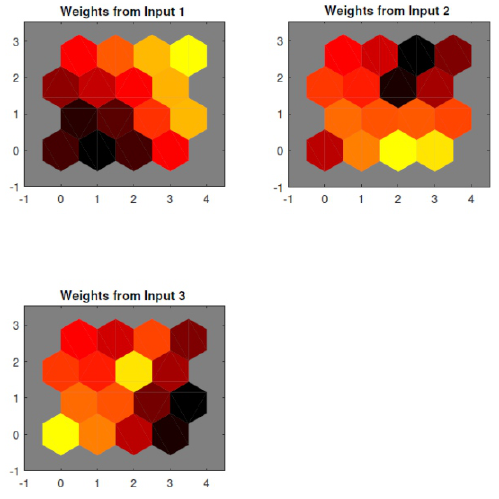
Figure 9. Self Organizing Map (SOM) input planes per phase of the